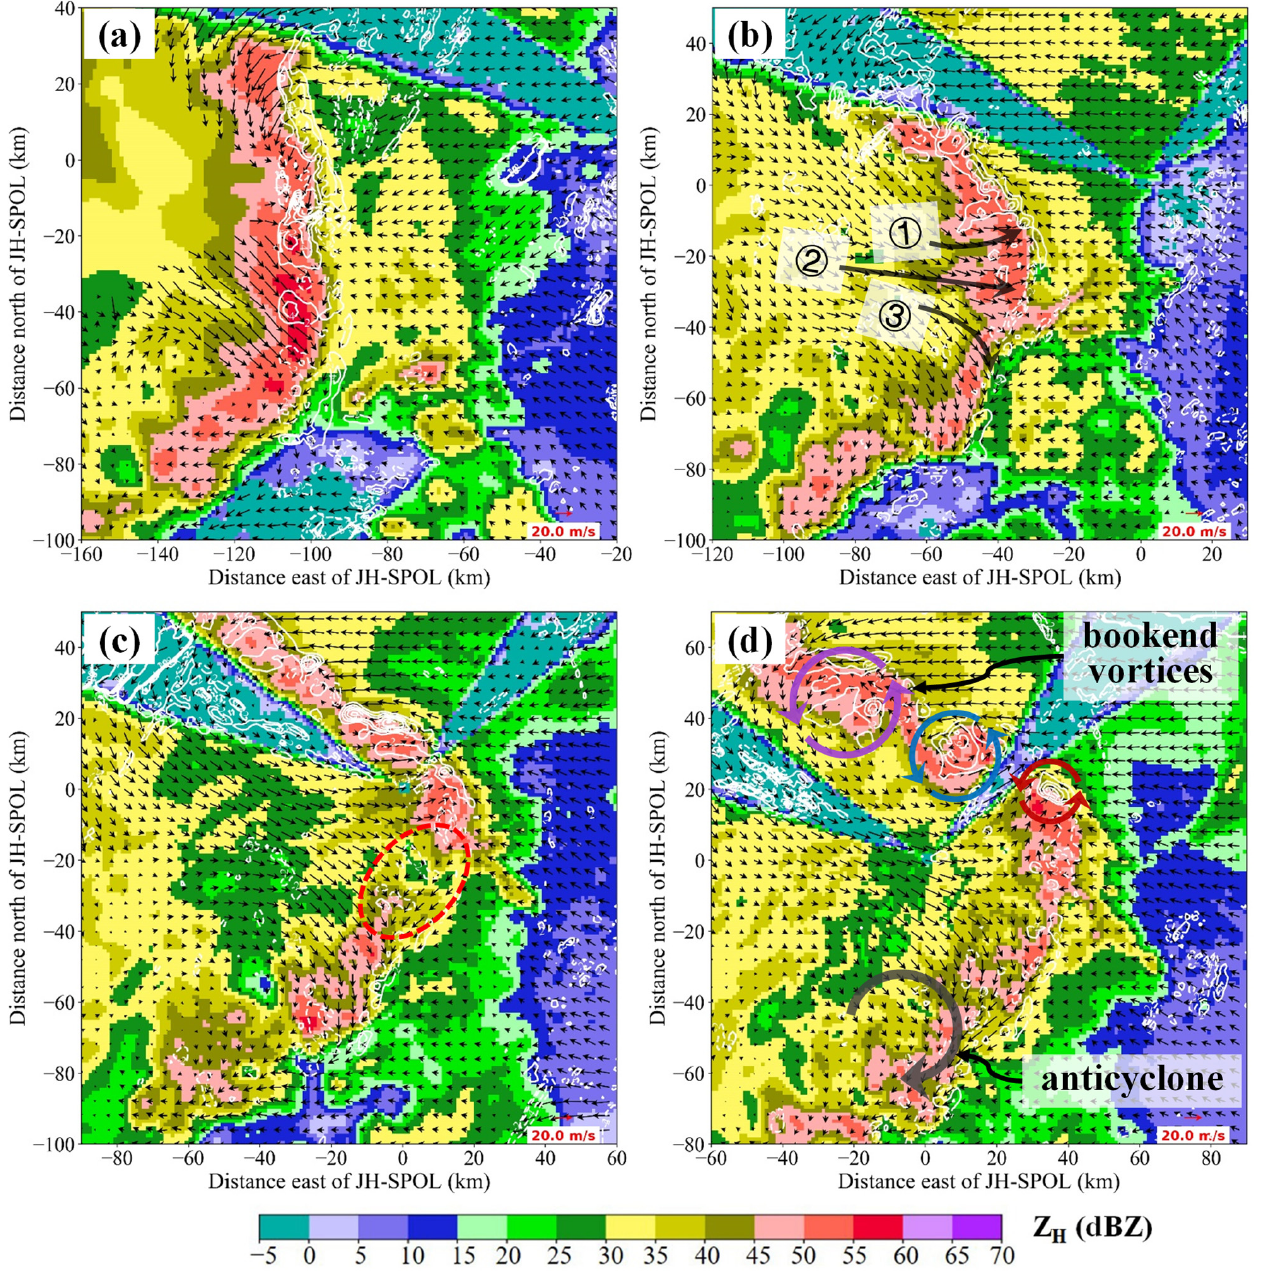
Figure 5. Horizontal storm-relative wind fields at a height of 1.5 km at ( a ) 2132, ( b ) 2212, ( c ) 2242, and ( d ) 2300 BT on 10 May 2021, as retrieved from a combination of QZ-SPOL, JH-SPOL, and LSRD data. The solid and dashed white lines indicate the positive and negative vertical vorticity contours, respectively (unit: 10 –3 s –1 ).